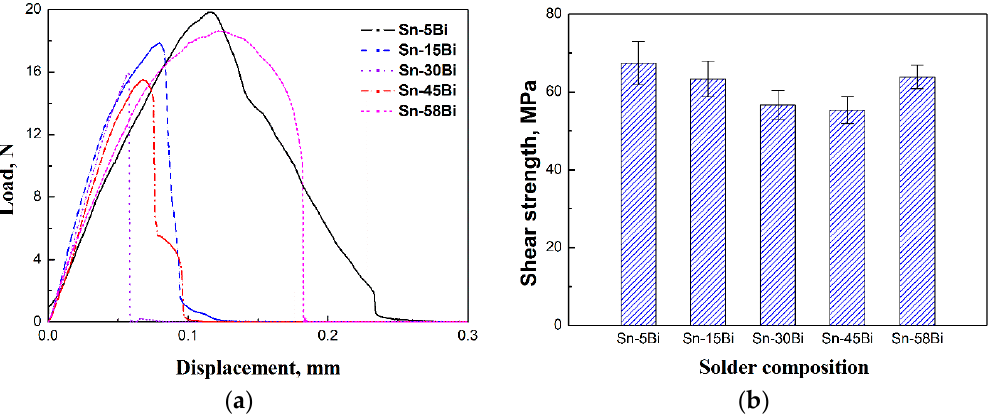
Figure 10. Effect of Bi content in Sn-Bi as-soldered joints on ( a ) load-displacement curves and ( b ) shear strength.